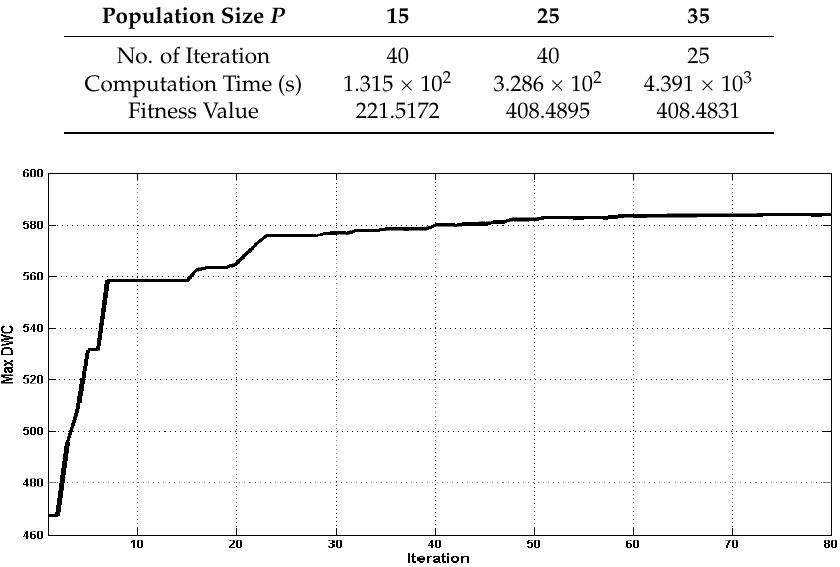
Figure 7. Maximum allowable dynamic wrench capability versus iteration number for base point locations being displaced individually.